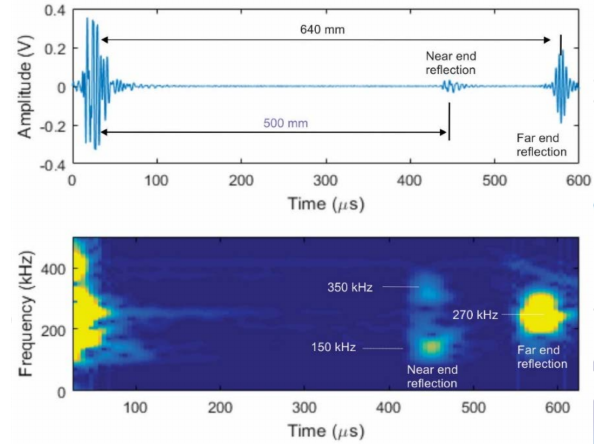
Figure 11. Reflections obtained from the ends of the stainless steel plate with the arrangement shown in Figure 10 (upper image), and the spectrogram of signals obtained from the opposite plate edges (lower